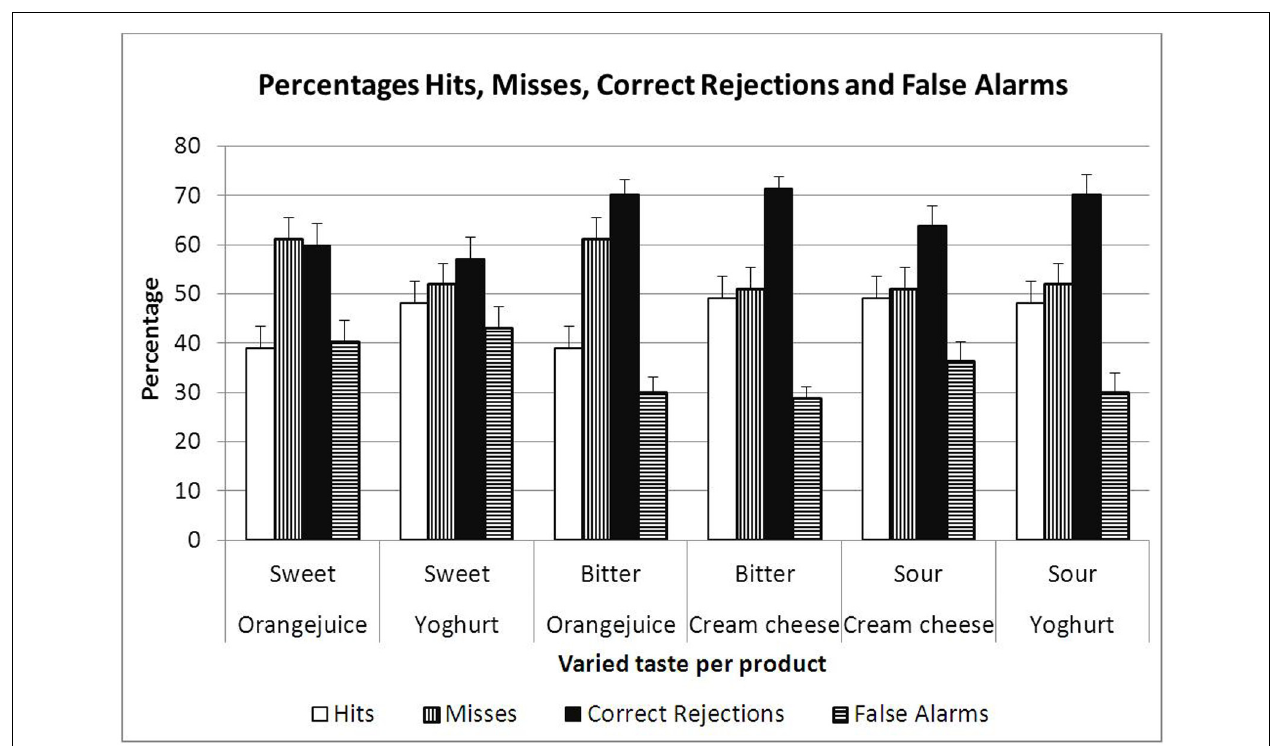
FIGURE 1 | Percentages of the four response types in each of six taste memory tests by Köster etal.